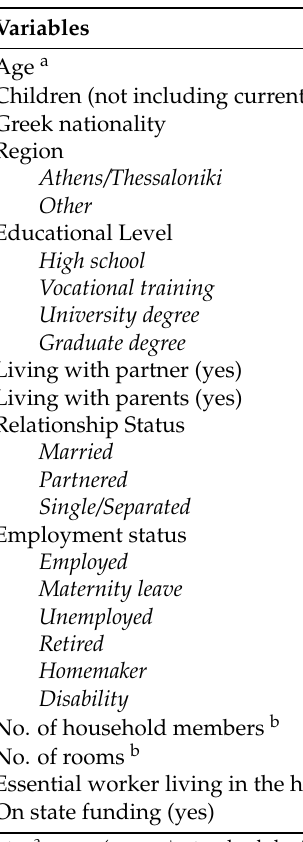
Table 1. Sociodemographic characteristics of the sample ( N = 308).